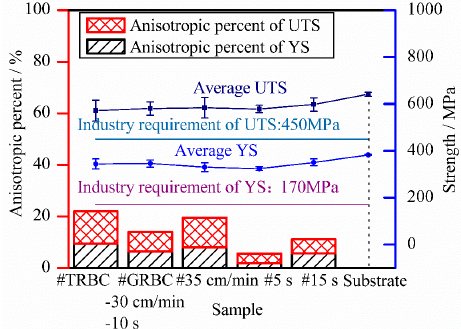
Figure 13. Anisotropic percentage and average of horizontal and vertical ultimate tensile strengths (UTSH and UTSV, respectively), and horizontal and vertical yield strengths (YSH and YSV, respectively) of different samples. (TRBC and GRBC represent transient and gradual reduction of bottom current, respectively).